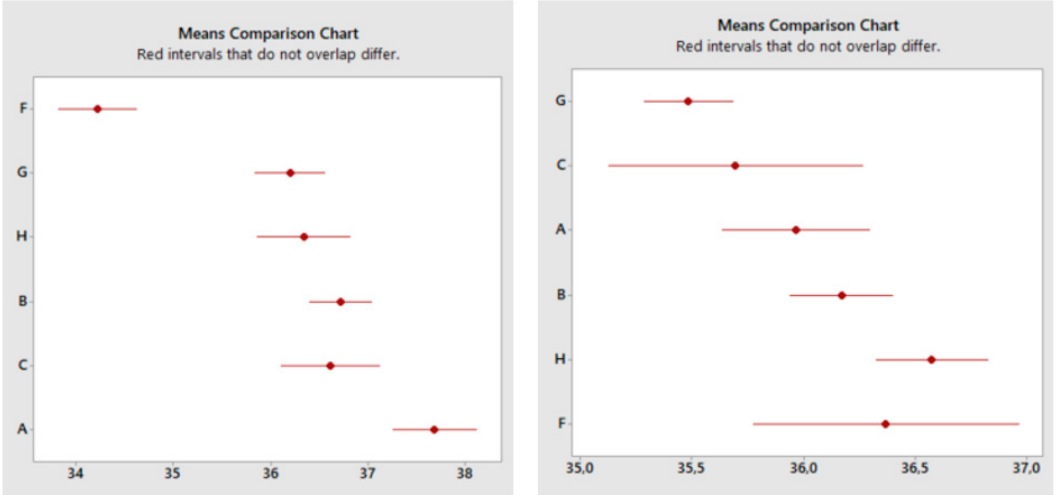
Figure 27. Residual defect, company C: XY face ( left ), XZ face ( right ).